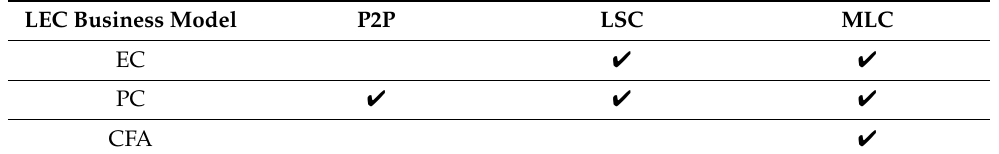
Table 1. Asset dispatch methods that apply to different LEC business models. LEC Business